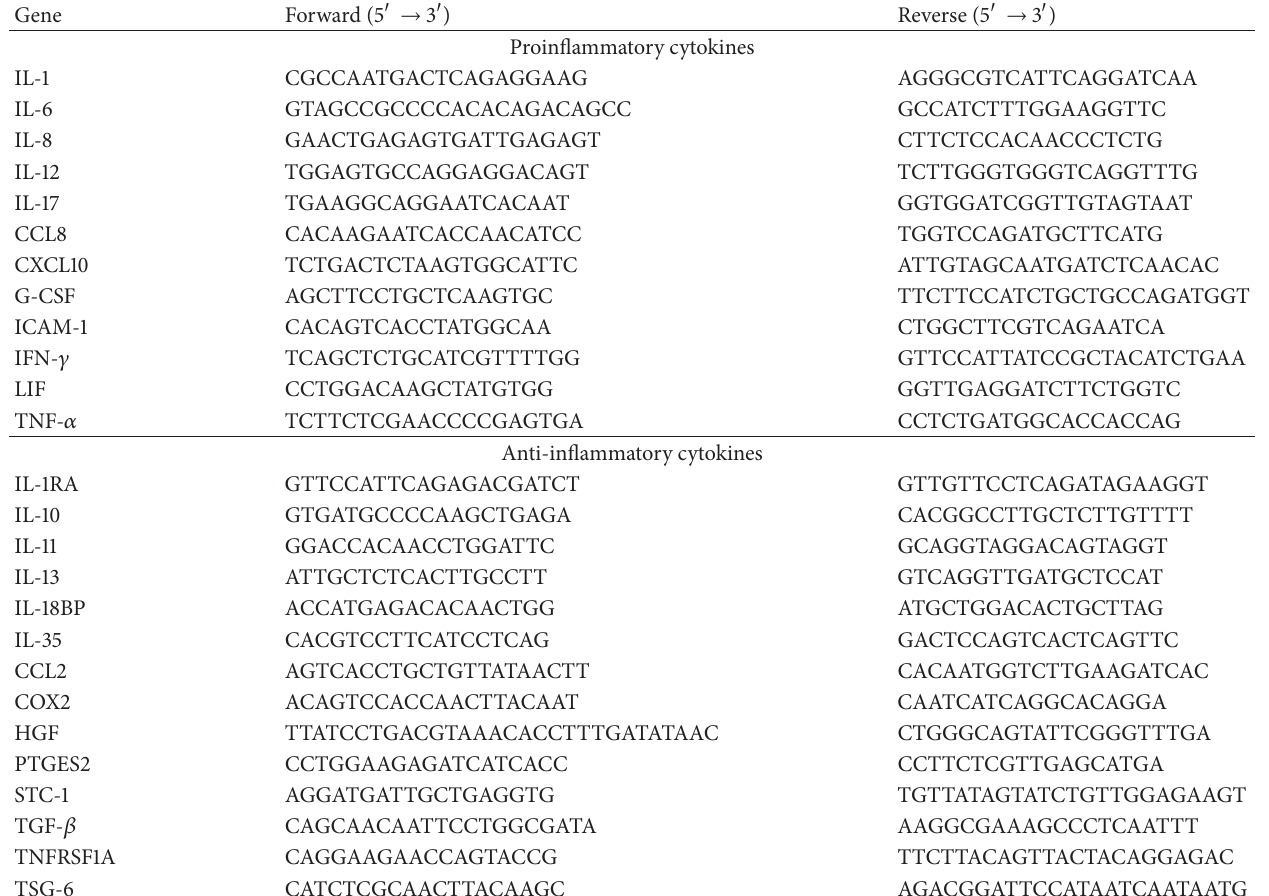
Table 1: qRT-PCR primer sequences for proinflammatory and anti-inflammatory